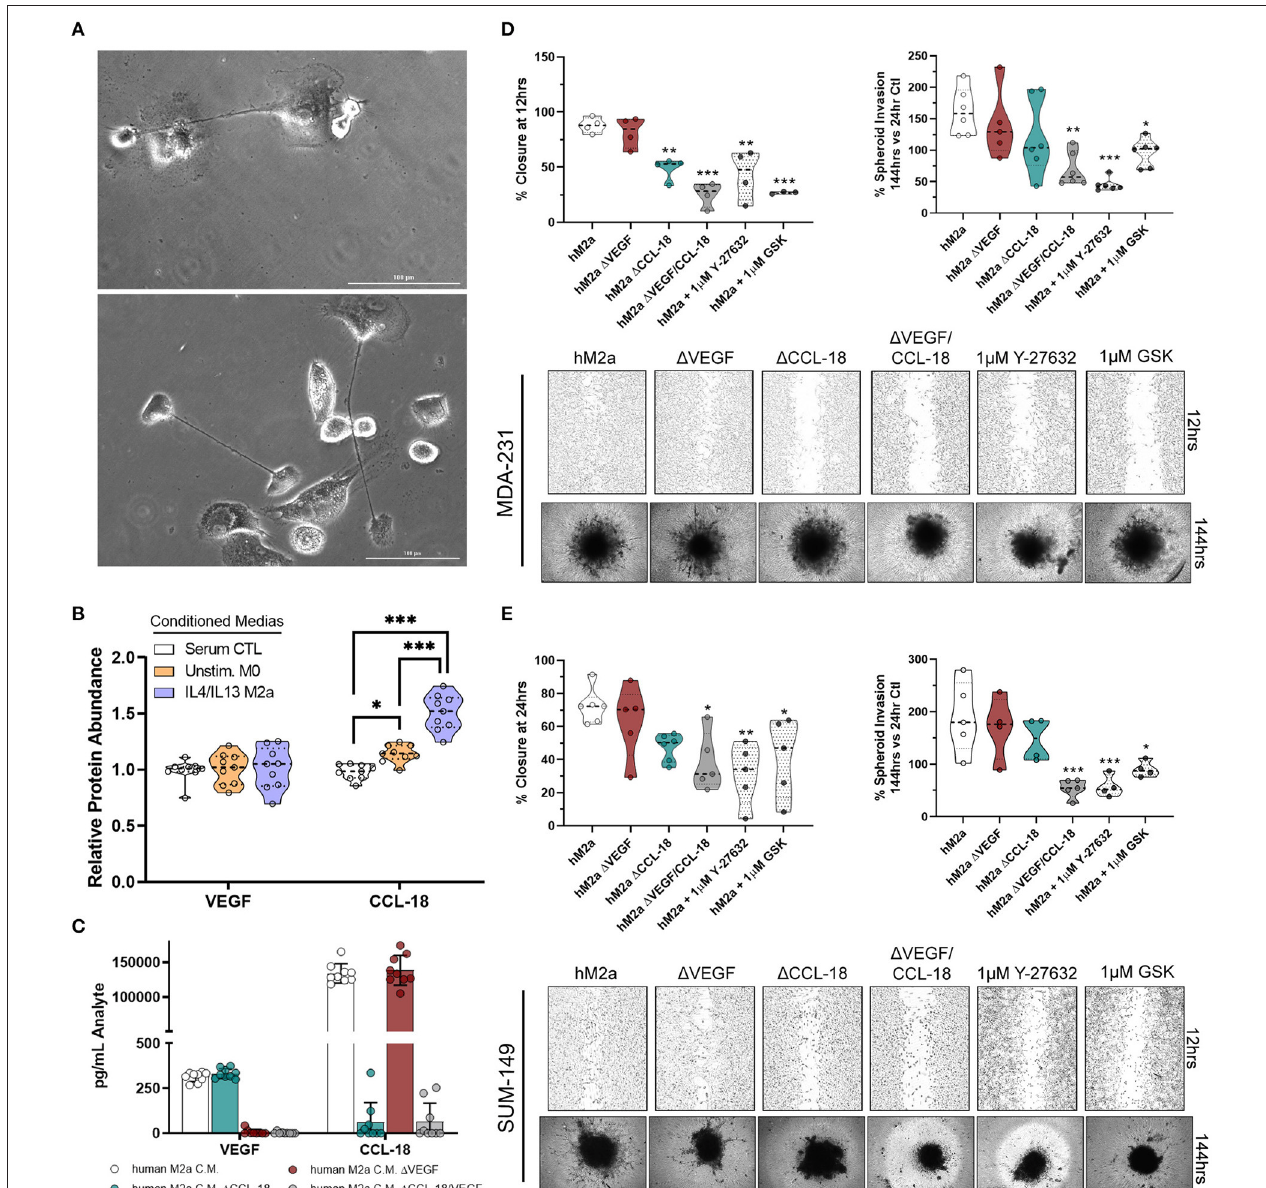
FIGURE 6 | Human M2a macrophages enhance breast cancer cell migration and invasion through VEGF/CCL-18 signaling regulated by Rho-GTPases. 40X phase contrast images of fully differentiated human macrophages (A) . ELISA results from concentrated conditioned media extracts from normal human macrophage growth media (serum containing; white), unstimulated M-CSF differentiated macrophages (orange), and IL-4/IL-13 polarized human M2a macrophages (purple/blue) (B) . ELISA results from analyte removal assays (C) . Results of wound closure 12h post wound (left panel) or spheroid invasion 144h post treatment/supplementation (right panel) experiments utilizing either human M2a conditioned media (M2a) analyte depleted hM2a media (e.g., hM2a 1 VEGF) or pretreatment with ROCK inhibitors with hM2a macrophage conditioned media in MDA-231 cells (D) . Representative images of either wound closure (top) or spheroid invasion (bottom) experiments in MDA-231 cells are shown below quantified data. Similar results displayed for wound closure (left panel) or spheroid invasion (right panel) with representative images below quantified data for SUM-149 cells (E) . All results are compiled from ≥ 2 independent experiments; Statistical significance was determined by one-way ANOVA; error bars represent ± standard deviation; p -value is displayed as * p < 0.05, ** p < 0.01, *** p <